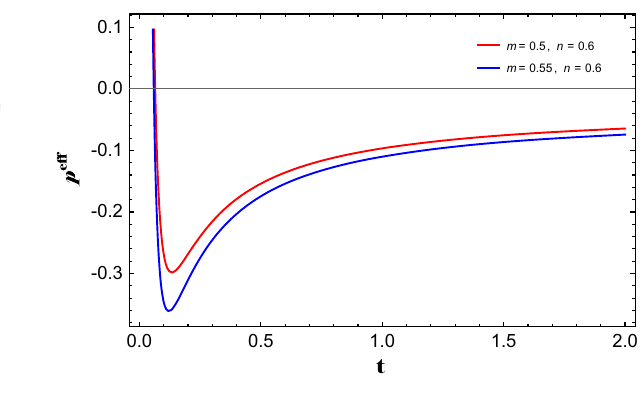
Fig. 3 ρ eff + 3 p eff vs. t , with n = 0 . 6